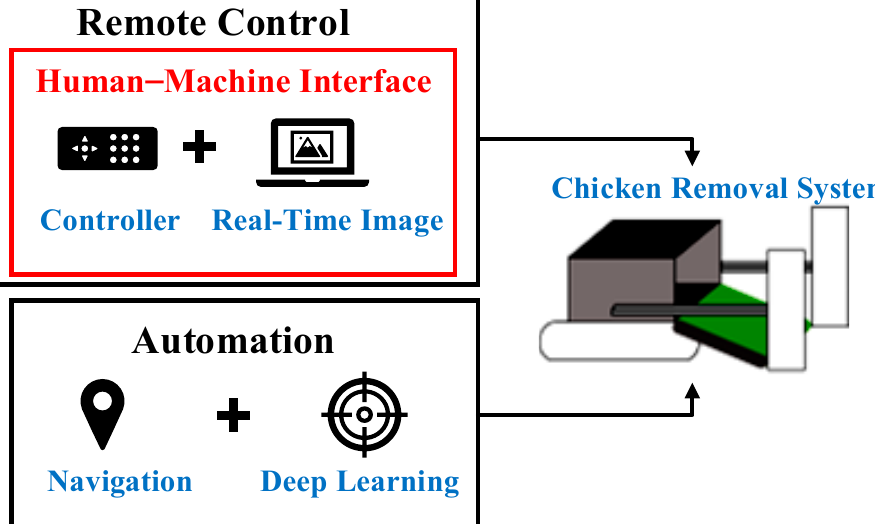
Figure 1. The concept of the small chicken removal system.